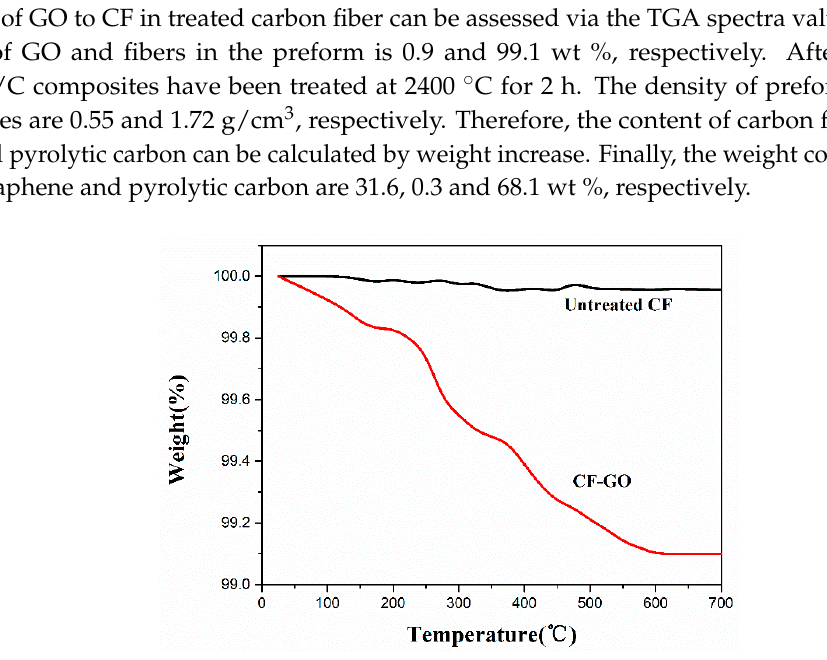
Figure 6. TGA curves of untreated and grafted carbon fiber.